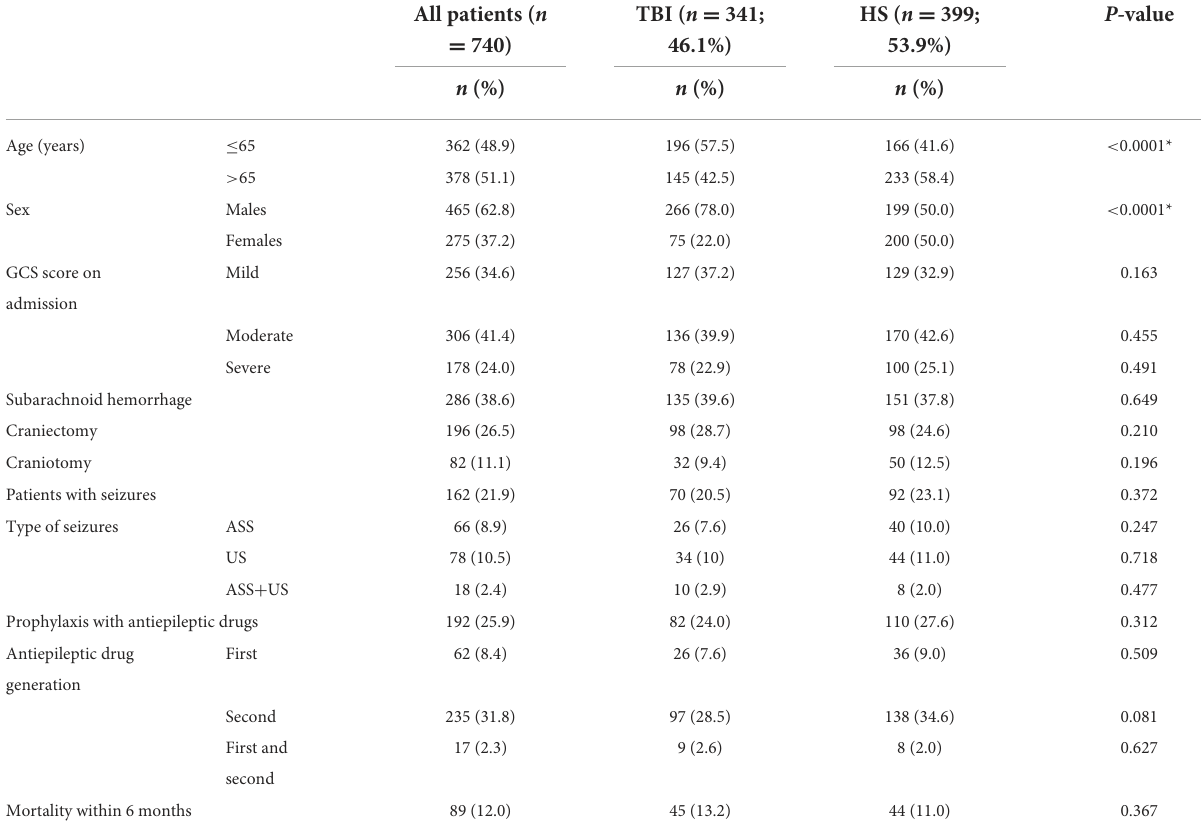
TABLE 1 Clinical and demographic characteristics of patients with acquired brain injury according to type of